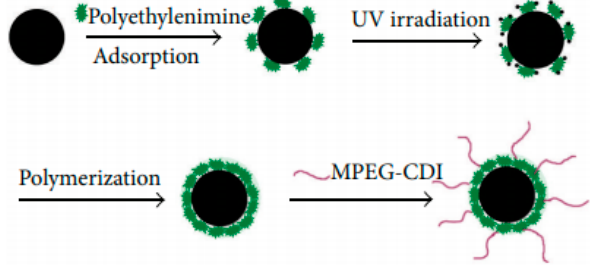
Figure 9. Schematic representation of the MPEG-PEI-SPIONs fabrication process. Reproduced from Zhang, Y.; Zhang, L.; Song, X.; Gu, X.; Sun, H.; Fu, C.; Meng, F. “Synthesis of Superparamagnetic Iron Oxide Nanoparticles Modified with MPEG-PEI via Photochemistry as New MRI Contrast Agent.” J. Nanomater. (2015) 417389.